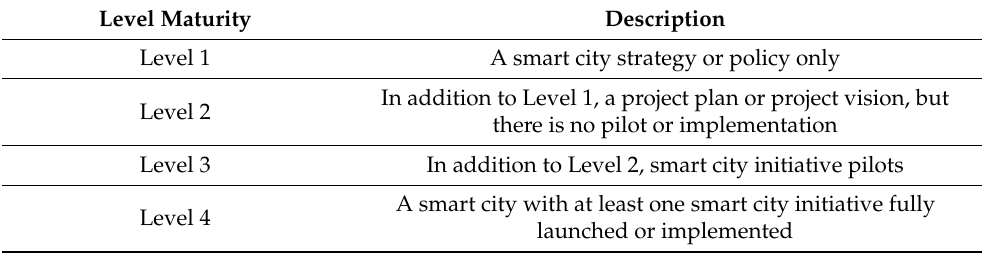
Table 2. Smart cities maturity